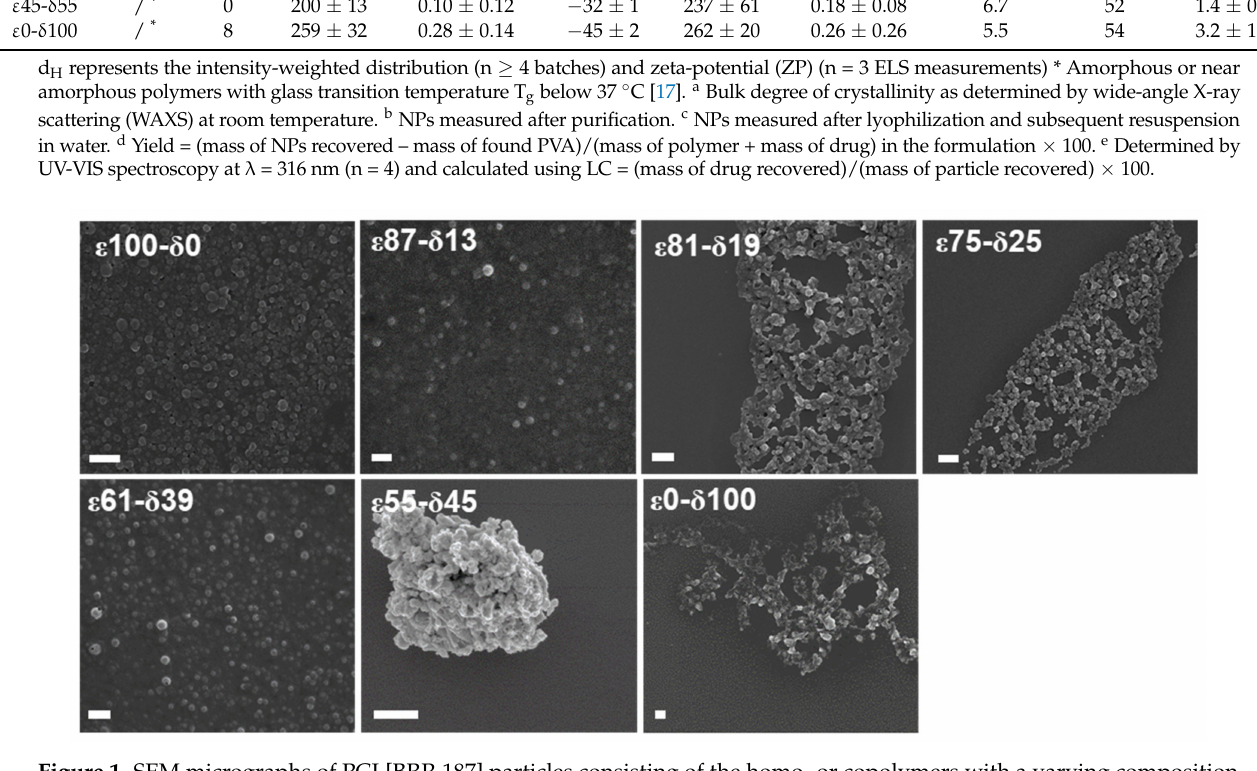
Figure 1. SEM micrographs of PCL[BRP-187] particles consisting of the homo- or copolymers with a varying composition. Scale bar = 1 µ